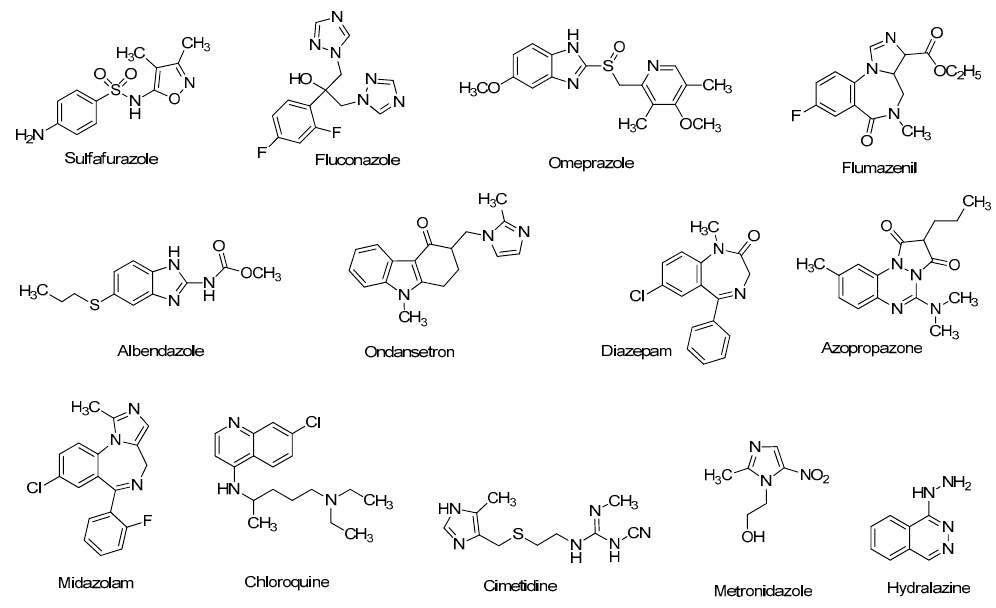
Figure 1. Glimpse of marketed drugs containing heterocycles.